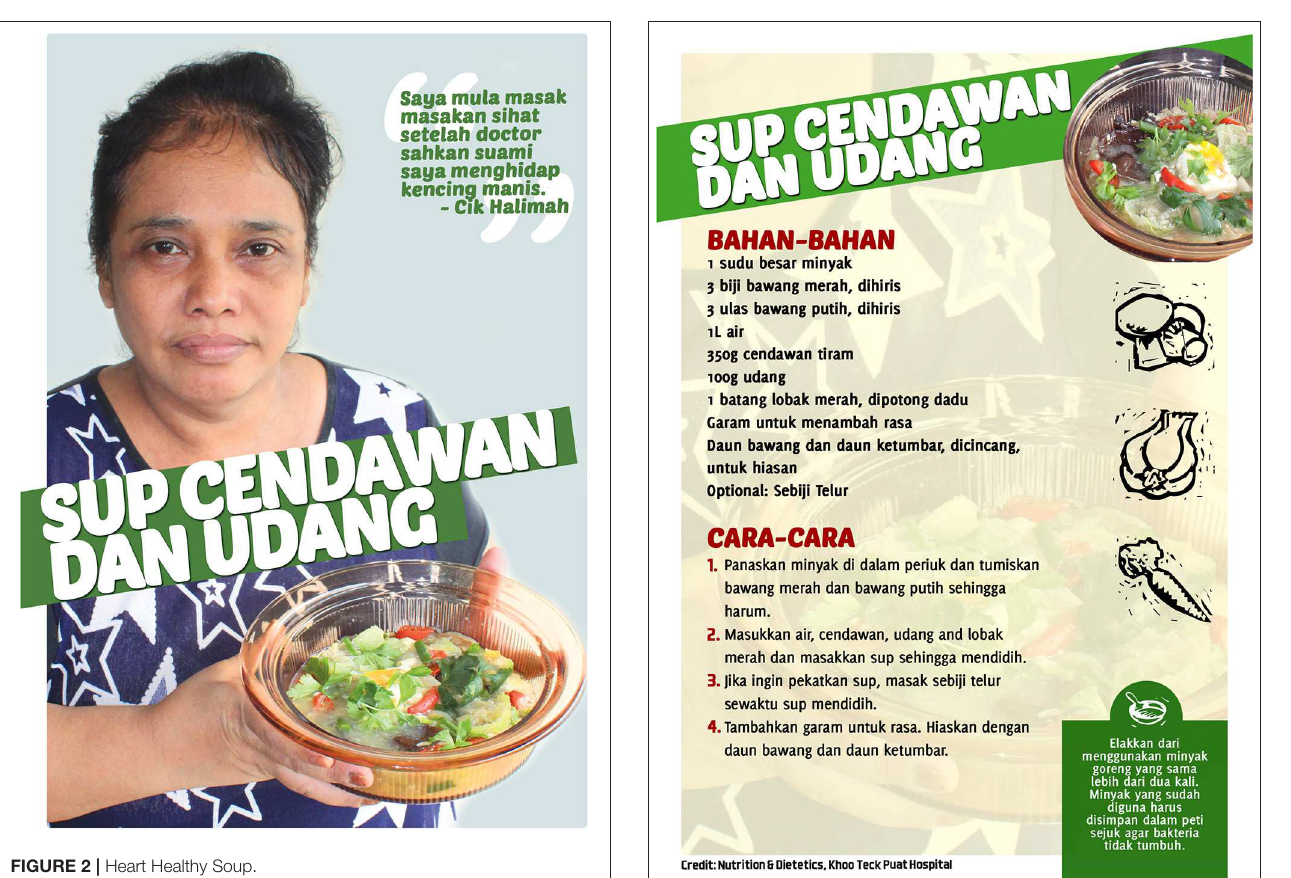
FIGURE 2 | Heart Healthy